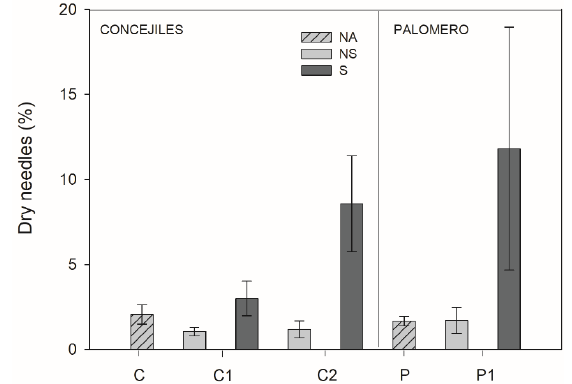
Figure 6. Proportion of dry needles versus normal needles per branch (%), measured in each pine stand and disease degree. The striped dark gray bars show the values for the NA-trees; the smooth